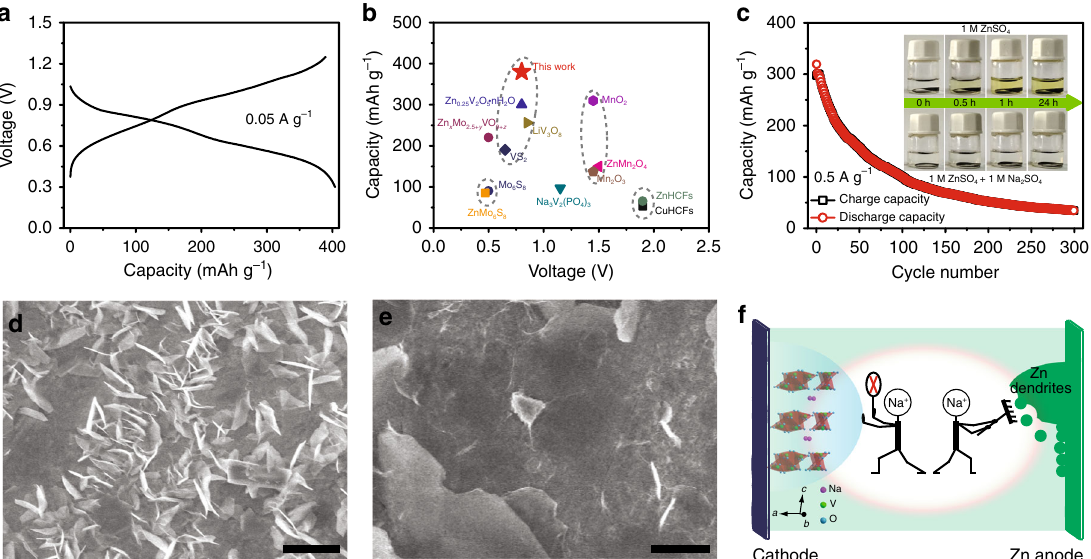
Fig. 2 Electrochemical performance of Zn/NVO batteries in 1 M ZnSO 4 electrolyte and function of Na 2 SO 4 electrolyte additive. a First charge/discharge curve of NVO electrode in ZnSO 4 electrolyte. b Comparison of reversible capacity and operating voltage between NVO nanobelts and other reported positive electrode materials. c Cycling performance of NVO electrode in ZnSO 4 electrolyte. The insets are optical images of NVO electrodes in ZnSO 4 and ZnSO 4 /Na 2 SO 4 electrolytes for different periods. SEM images of the Zn negative electrode surface from Zn/steel mesh batteries after one CV cycle from – 0.2 to 0.3 V in d